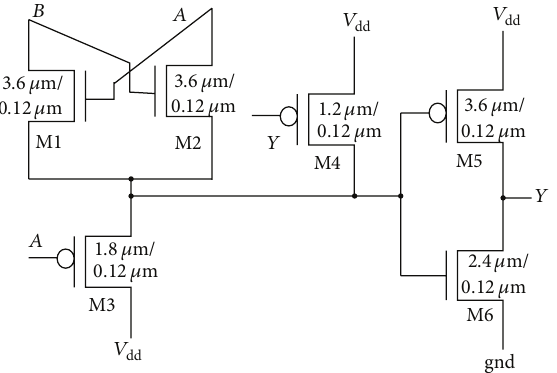
Figure 1: Circuit diagram of the proposed six-transistor pass- transistor-based full-swing CMOS XOR